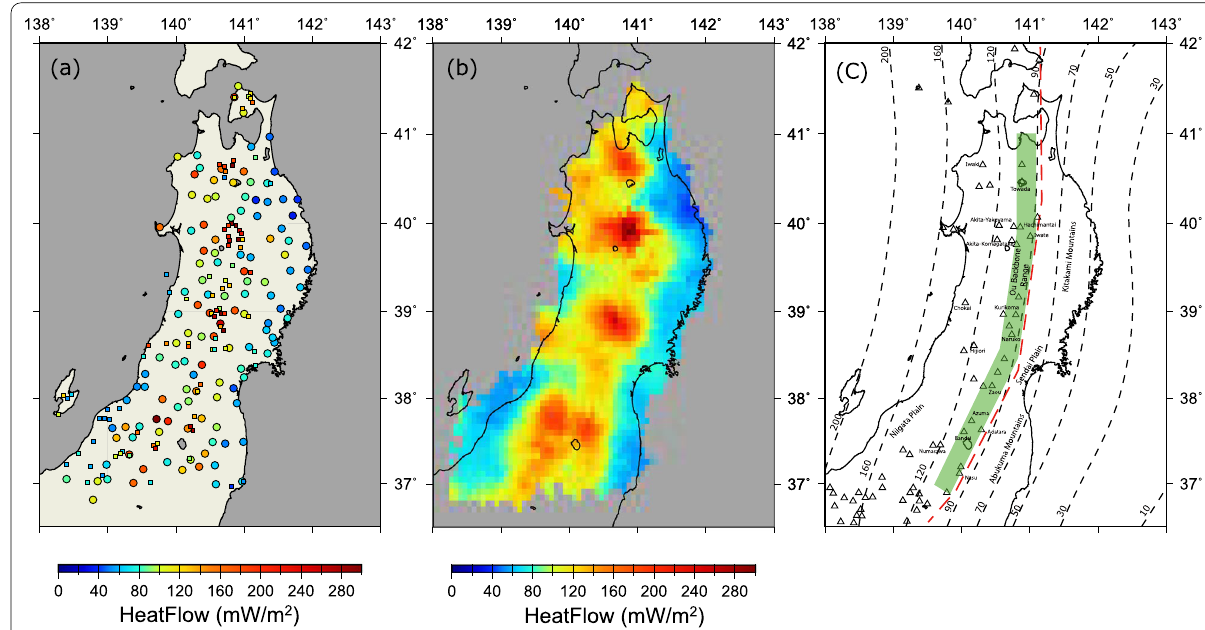
Fig. 6 Distribution of terrestrial heat flow. a Plots the heat flow rate at each measurement point. The circles indicate the heat flow at the Hi-net station, and the squares indicate the heat flow at the DTPBJ (Sakagawa et al. 2004). b Is plotted by interpolation using the Nearest neighbor method (nearest neighbor method). The grid size is set to 4 min. Triangles in c indicate volcanoes in Northeastern Japan. The red dashed line indicates the volcanic front (Yoshida et al. 2013). The green hatch area indicates the location of the Ou Backbone Range. Dashed continuous lines indicate depth